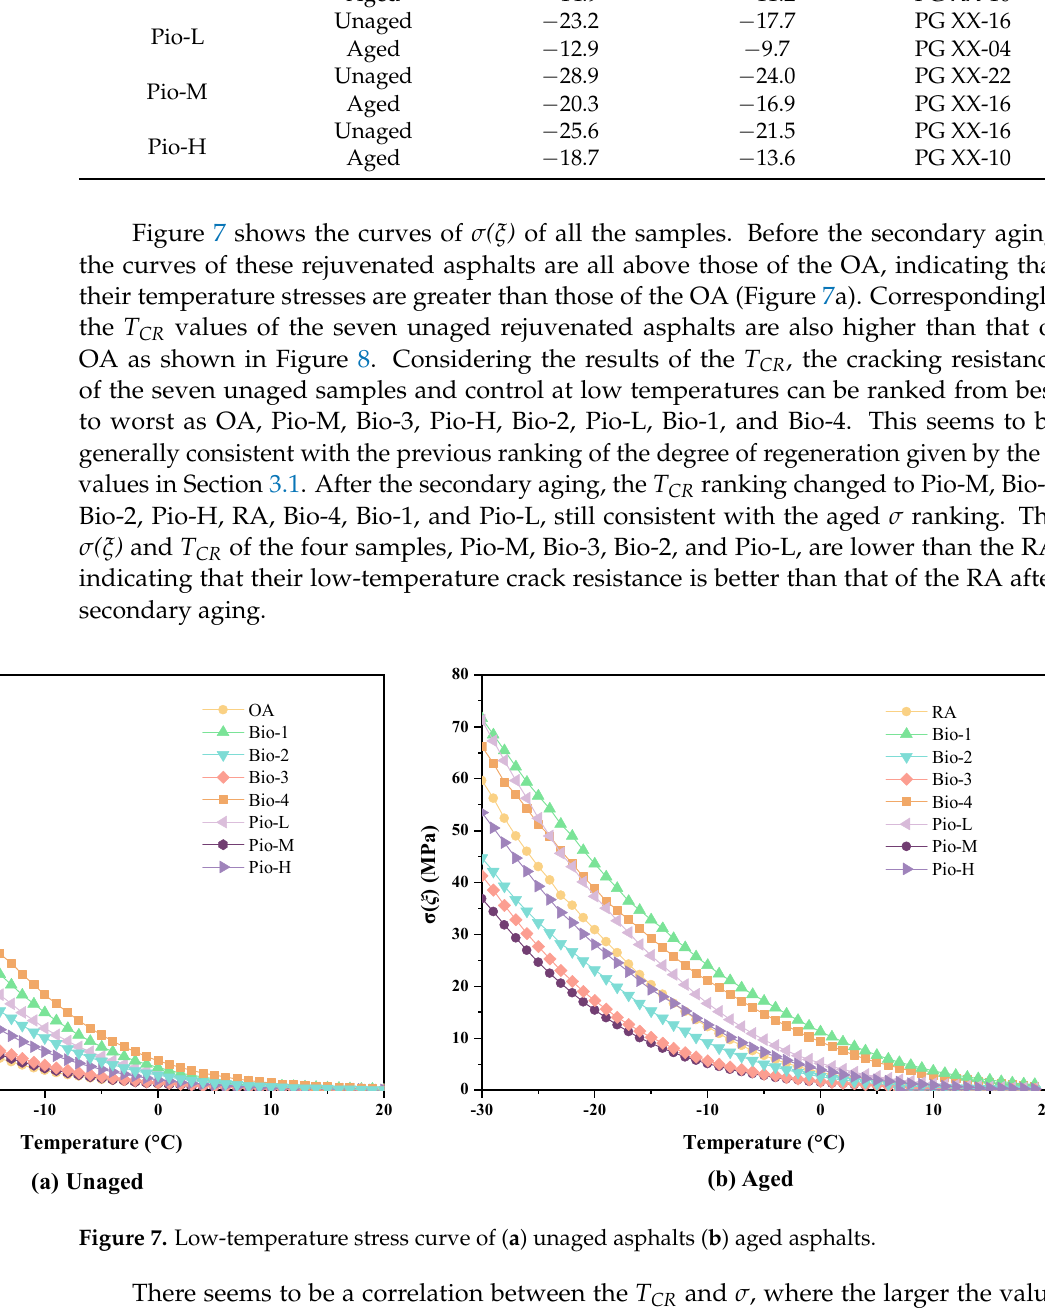
Figure 8. Critical cracking temperature ( T CR ) of all the asphalt samples.